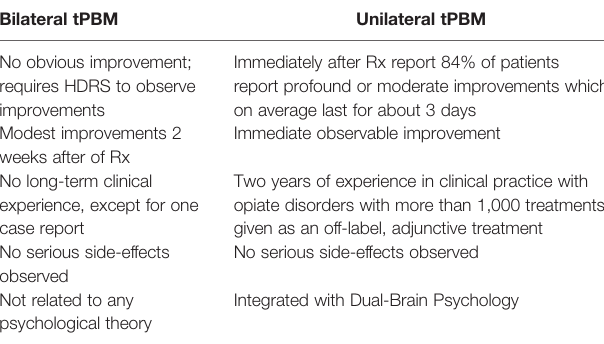
TABLE 1 | A comparison of bilateral tPBM and unilateral tPBM.